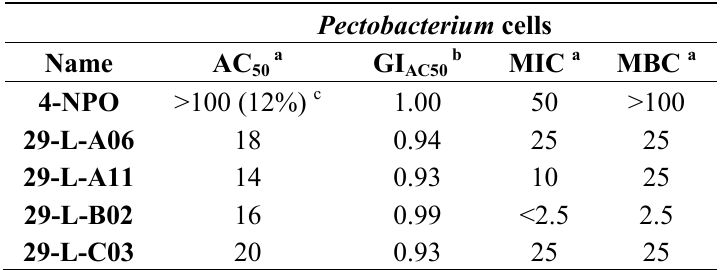
Table 1. Biological characteristics of the four identified